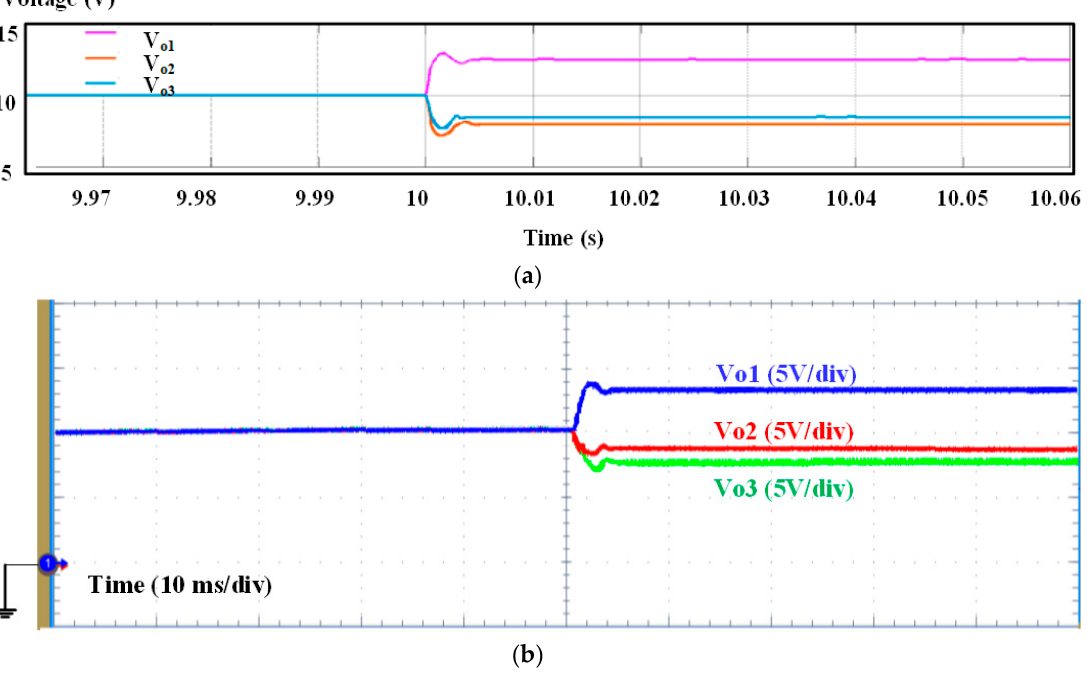
Figure 9. Waveforms for three battery module output voltage when the reference voltages were changed from V MX1-DC-ref = V MX2-DC-ref = V MX3-DC-ref = 10 V to V MX1-DC-ref = 13 V, V MX2-DC-ref = 9 V and V MX3-DC- ref = 8 V, ( a ) simulation results and ( b ) hardware experimental results.